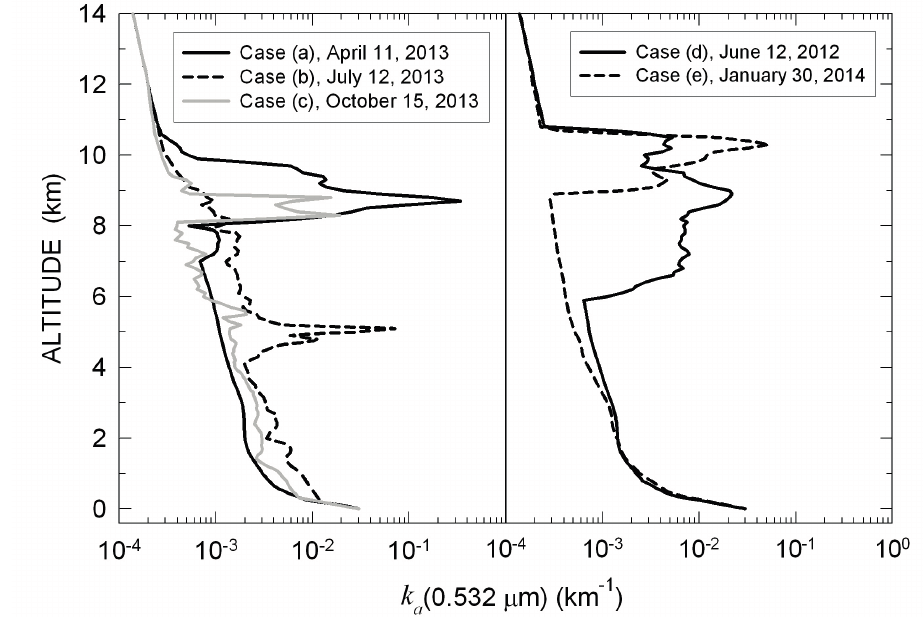
Figure 5. Left-hand side: Vertical profiles of volume extinction coefficient k a ( 0.532  m ) obtained from the KARL lidar measurements conducted at Ny-Ålesund (~79°N) for thin cirrus clouds at various tropospheric altitudes and measured on 11 April (15:10 UTC) (case (a)), 12 July (14:49 UTC) (case (b)), and 15 October (12:49 UTC) (case (c)). Each of these three profiles was superimposed to the corresponding monthly (or multi-monthly) mean vertical profile of k a ( 0.532  m ) shown in Figure 2 obtained from the KARL lidar measurements conducted in April, June − July and October–December 2013, respectively. Right-hand side: as in the left-hand side, but for the vertical profiles of k a ( 0.532  m ) derived from the University of Rome/ENEA lidar measurements conducted at Thule (  77°N) on June 12, 2012 (from 11:09 to 12:14 UTC) (case (d)) and January 30, 2014 (from 19:12 to 20:42 UTC) (case (e)). The cirrus cloud profiles were superimposed over the corresponding monthly or bi-monthly mean vertical profile of coefficient k a ( 0.532  m